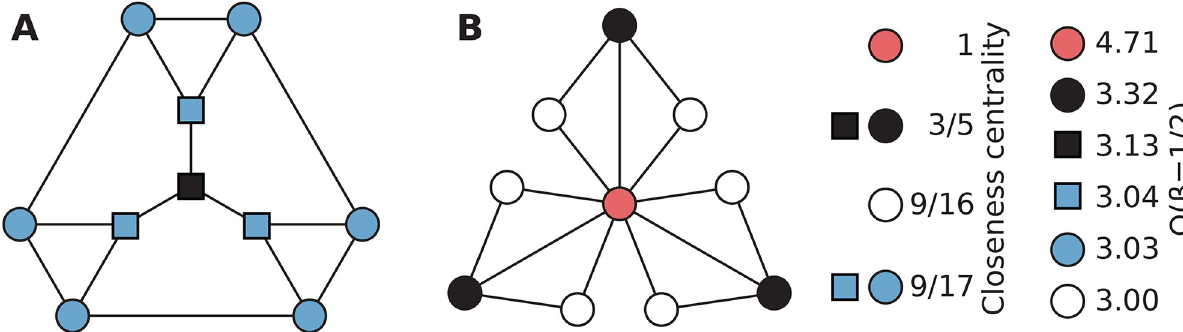
Fig 1. Comparing nodes in different graphs by closeness centrality and O . The black nodes in the two graphs all have closeness 3/5, which ranks them as the most important node in panel A but of intermediate importance in panel B. The value 3/5 is thus insufficient for ranking the nodes importance. Closeness manages to rank the nodes within each graph correctly with respect to O for the infection rate β = 1/2 (except it does not split the blue nodes of the graph in panel A), but ranks the white nodes of panel B too high in both graphs together.